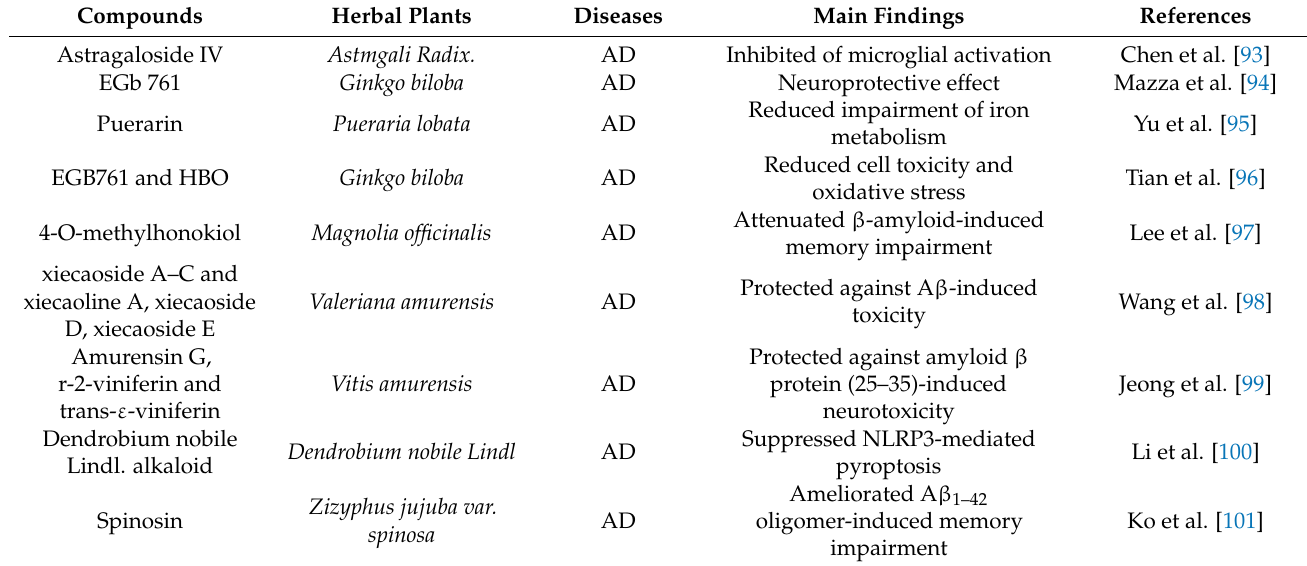
Table 4. Other bioactive compounds from herbal plants contribute to prevention of